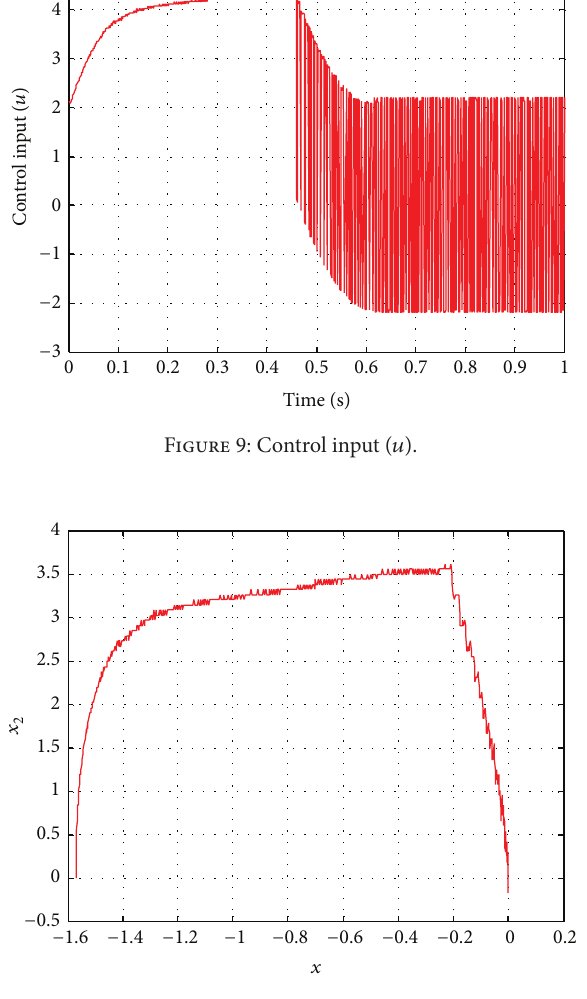
Figure 10: Phase portrait ( 𝑥 versus ̇𝑥